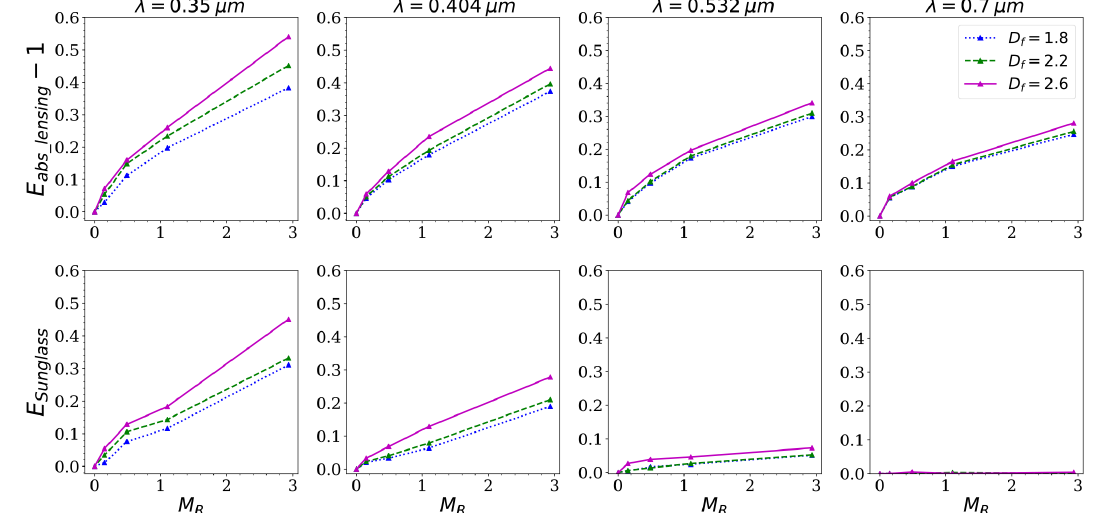
Figure 10. Similar to Fig. 8, but for E abs_lensing and E Sunglass .